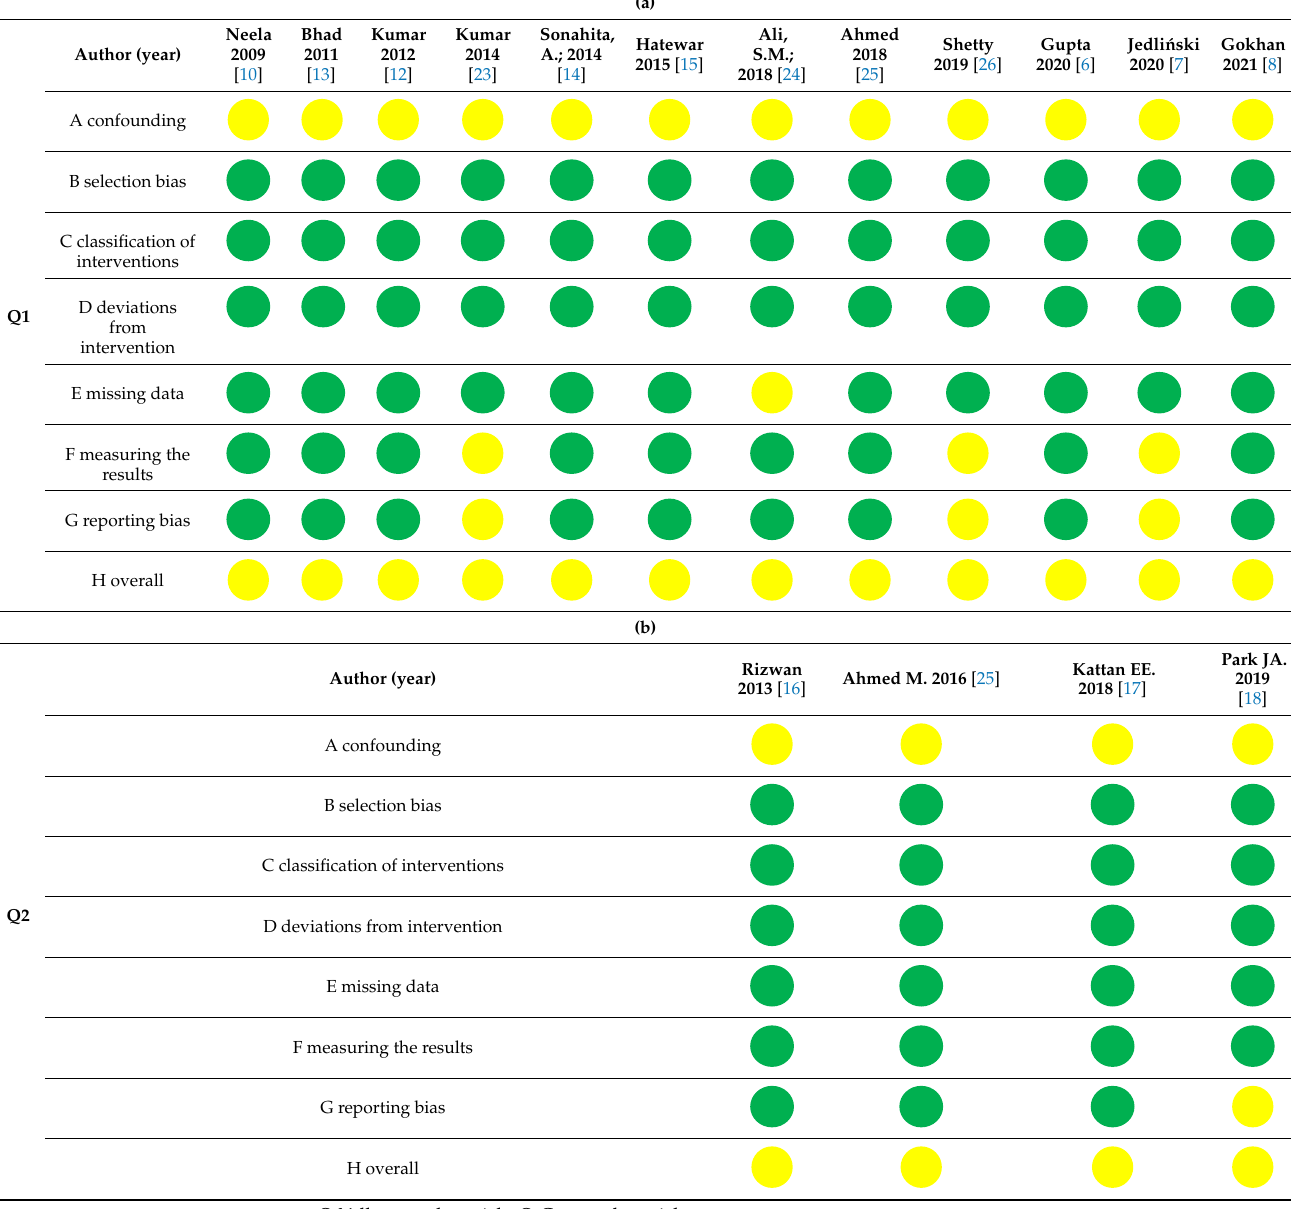
Table 3. (a) The evaluation of the conclusions according to the degree of evidence of articles dis- cussing new indicators of cephalometric analysis in relation to the sagittal plane. (b) The evaluation of the conclusions by degree of evidence of articles discussing new indicators of cephalometric anal- ysis in relation to the horizontal plane. Yellow — moderate level of evidence, Green — low level of evidence.